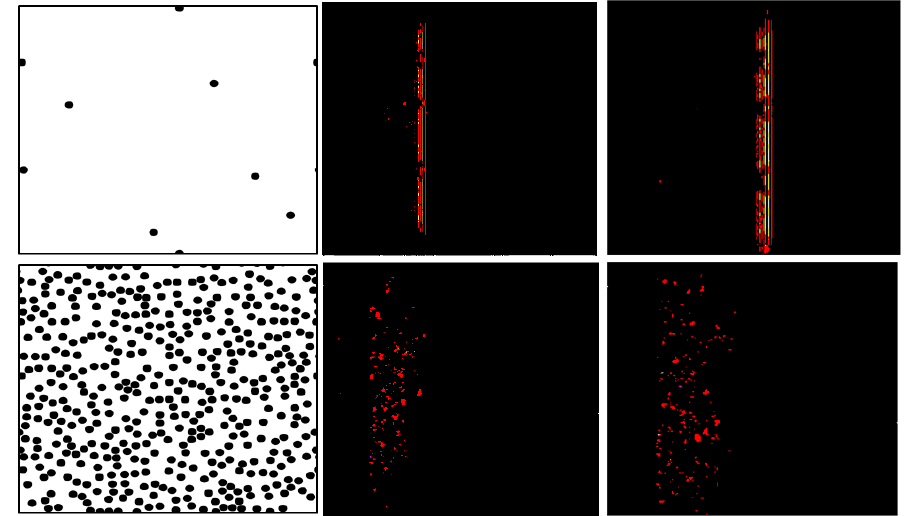
Figure 6. ( Left ): Two heterogeneous media with different scattering properties (top: weakly scattering medium, bottom: highly scattering medium). ( Center ) and ( right ): propagation of a plane in these two media at two different times. In the medium with a lower scatterer density, the wave makes rapid progress ( top ). In the medium with a dense scatterer distribution ( bottom ), the wave makes slower progress.